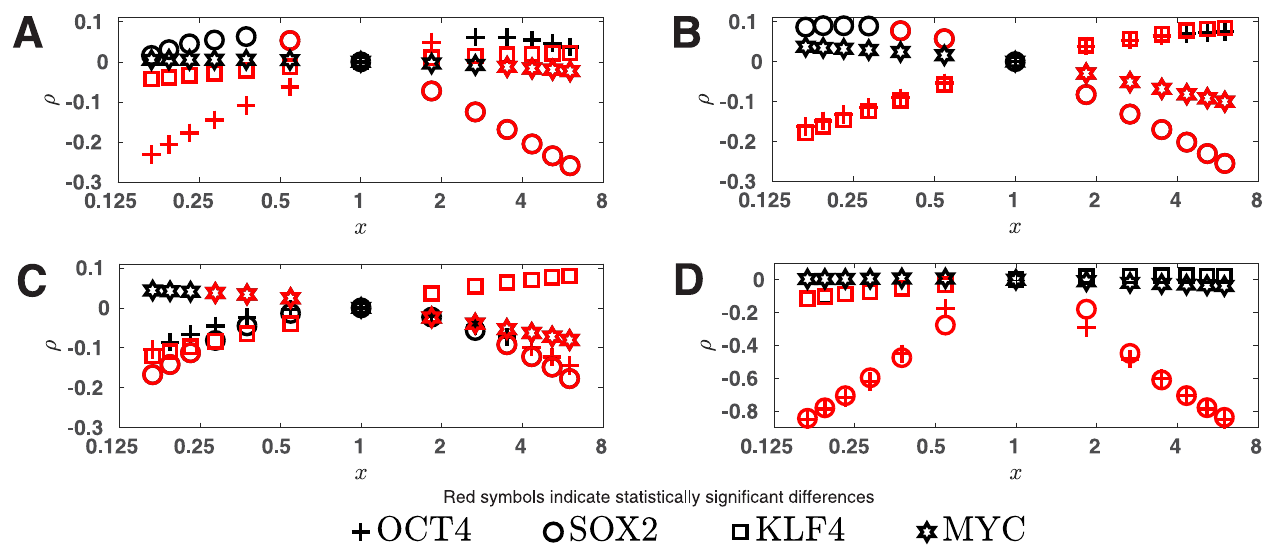
Fig 2. Effect of stoichiometry if the subnetworks are used. For different stoichiometric ratios (O:S:K:M) ρ , defined in Eq 10, are plotted as a function of x for (A) SUBN1, (B) SUBN2, (C) C 1 [ C 3 , and (D) C 2 [ C 3 . Here x is the relative decrease or increase in the level of one of the RFs while those of the rest of the RFs denotes the set of links in Class k (see text for definition). SUBN1 and SUBN2 are the two subnetworks comprising links in C 1 and remain unchanged. C k C 1 [ C 2 , respectively. A positive (negative) ρ is suggestive of a higher/lower IP efficiency.